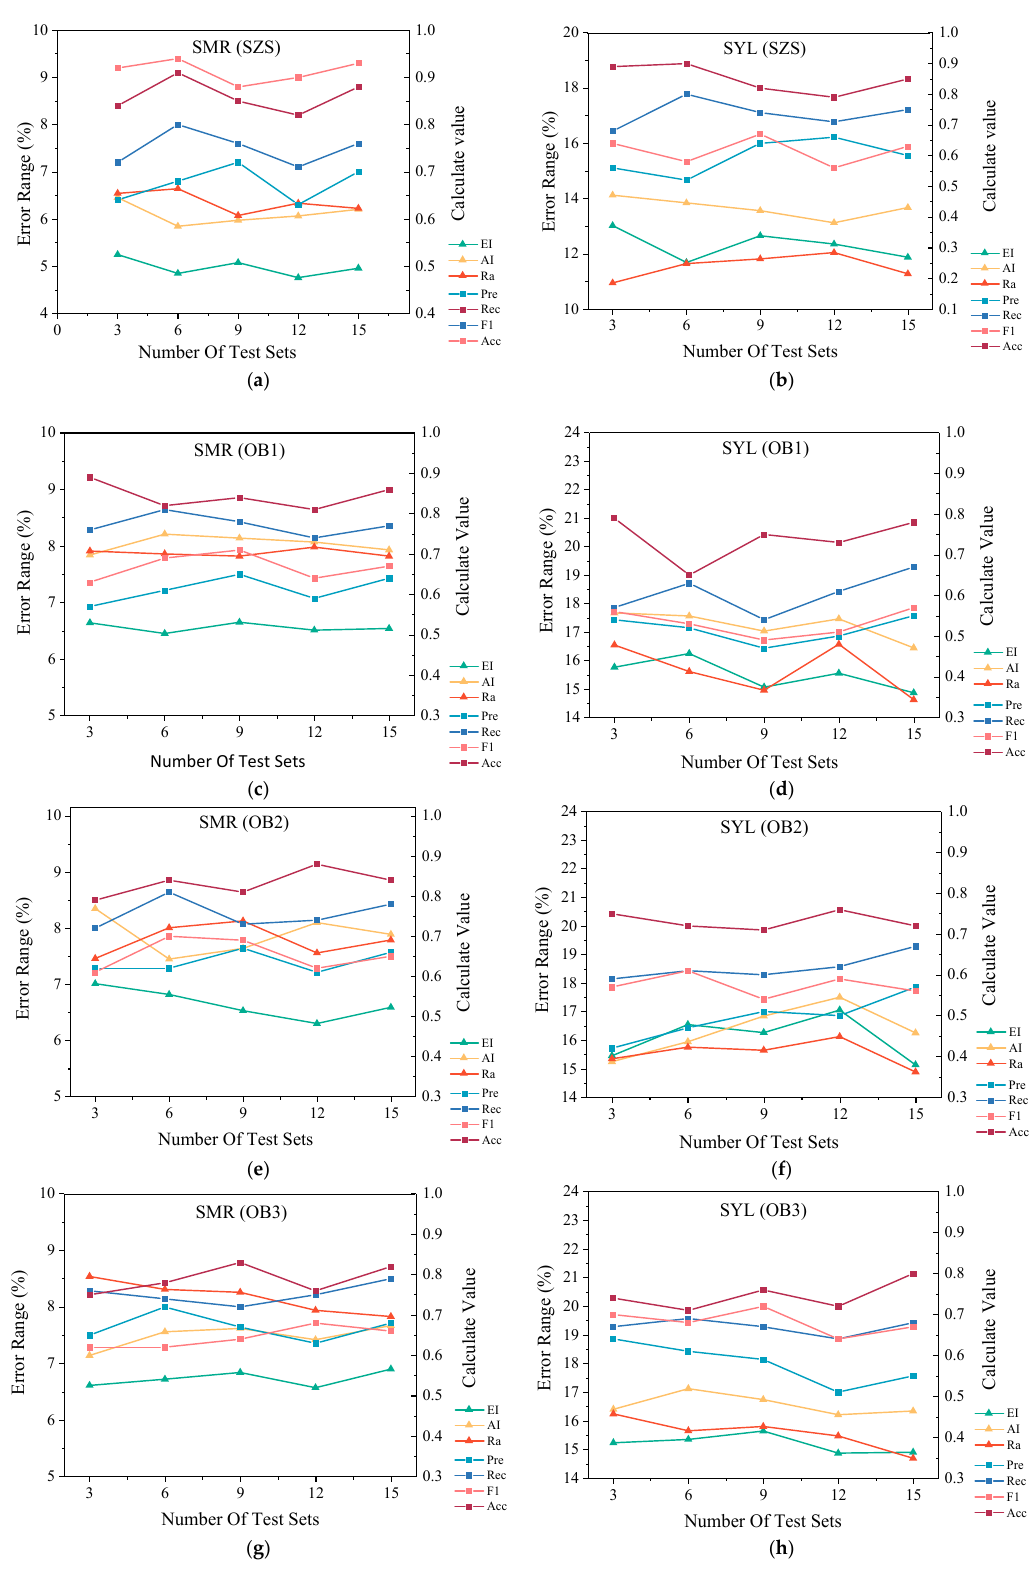
Figure 11. The comparison chart of the migration experiment results of the two algorithms: ( a ) represents the experimental results of SMR on the SZS dataset; ( b ) represents the experimental results of SYL on the SZS dataset; ( c , e , g ) represent the experimental results of SMR on OB1, OB2 and OB3 datasets; ( d , f , h ) represent the experimental results of SYL on OB1, OB2 and OB3 datasets.